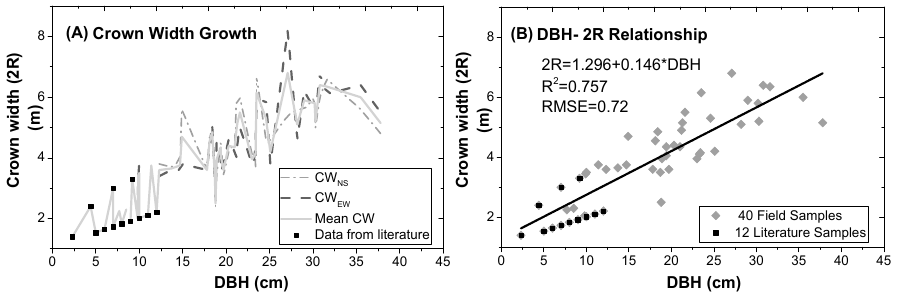
Figure A2. ( A ) Measured crown width (2 R ) for 40 sample trees with DBH in the north-south direction (CW NS ) and east-west direction (CW EW ); ( B ) Regression relationships between DBH and crown width ( 2R ).